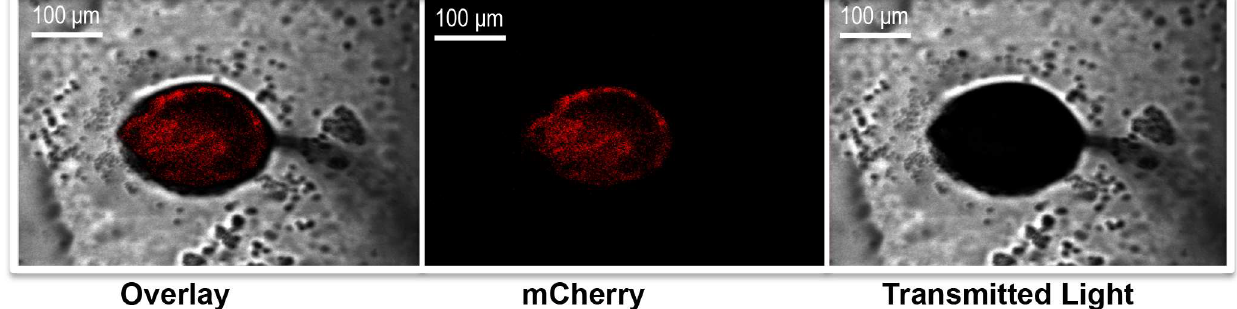
Fig 4. B . bronchiseptica localizes to the amoeba sorus. Fluorescence confocalmicroscopy imagingof D . discoideum fruiting body grown 16 d on a lawn of B . bronchiseptica RB50 pLC003(mCherry, red) at 10 ×